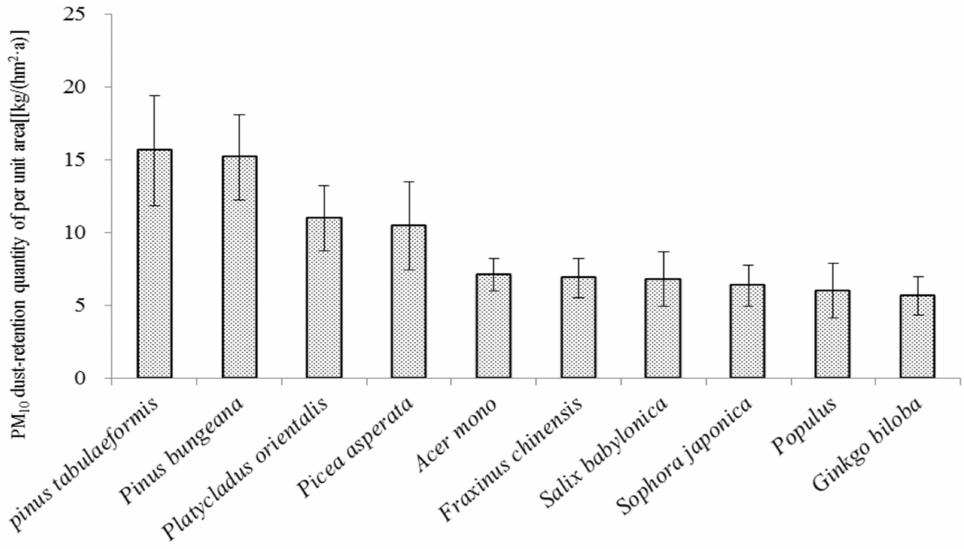
Figure 1. Annual PM 10 dust-retention capacity per hectare of different tree